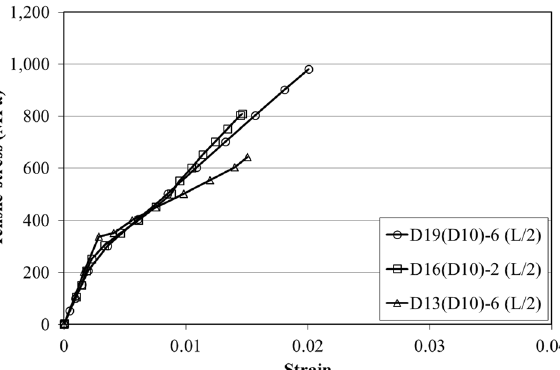
Fig. 7 Tensile stress–strain relationship according to the area of GFRP outer surface.